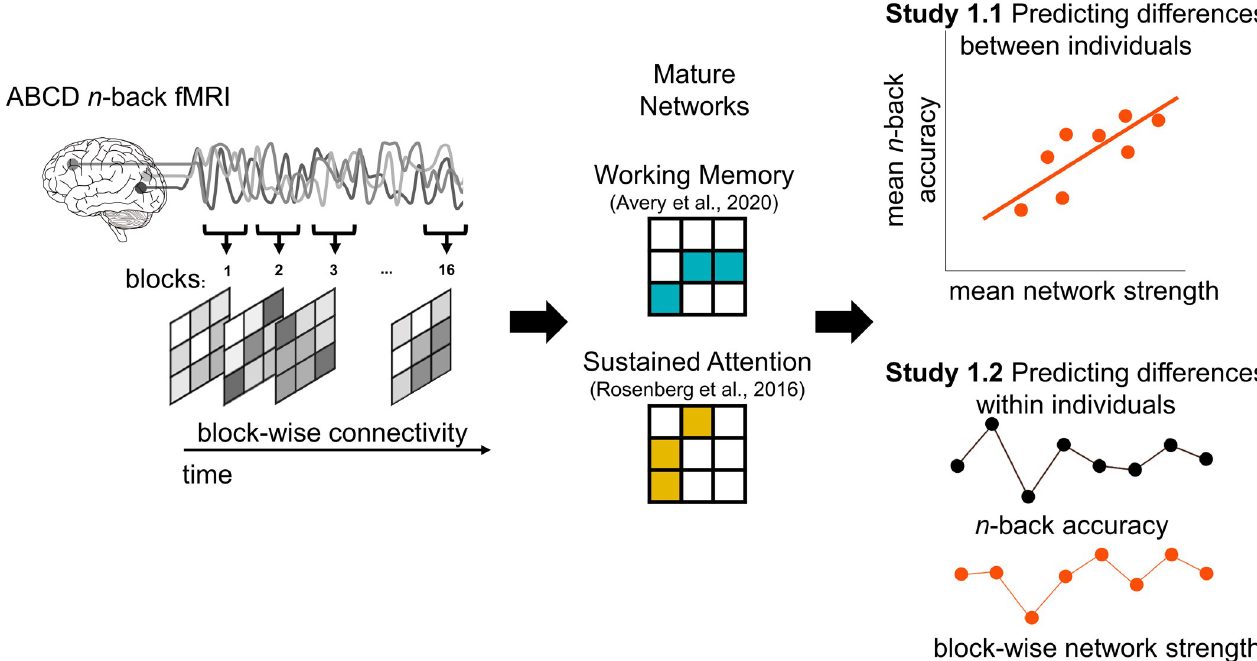
Fig 1. Overview of Study 1. First, we constructed block-wise FC by correlating BOLD signal time series from all pairs of functional parcels (left). For each participant, we calculated whole-brain FC patterns from fMRI data collected during the eight 0-back and eight 2-back tasks blocks. That is, we calculated up to 16 FC matrices per individual: 1 using data from each 25-s (30–31 volumes) n -back block separately. Each of the 2 predefined predictive network masks were then applied to each of these matrices to generate block-specific WM or SA network strength scores (middle). Each child’s mean network strength during 0-back and 2-back blocks was compared to their mean accuracy in 0-back and 2-back blocks (Study 1.1) or their mean out-of-scanner recognition memory for n -back stimuli (Study 1.3). In Study 1.2, block-to-block changes in network strength were compared to corresponding block-to-block changes in 0-back and 2-back accuracy within-subjects. ABCD, Adolescent Brain Cognitive Development; BOLD, blood-oxygen-level-dependent; fMRI, functional magnetic resonance imaging; SA, sustained attention; WM, working